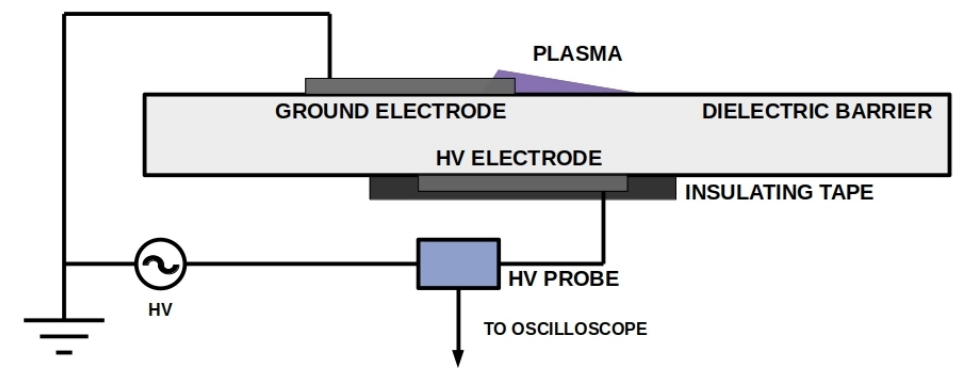
Figure 1. Plasma device scheme: The two electrodes, consisting of deposed copper (35 µ m thick, 4 cm wide, and 12cm long), are attached to a dielectric material and are laterally shifted from each other by about 0.5cm (typical asymmetry in SDBD). The lower electrode, fed at a high voltage (HV), is covered with an insulating material, whereas the upper one, fed to the ground, is exposed to air. The HV probe measures the applied